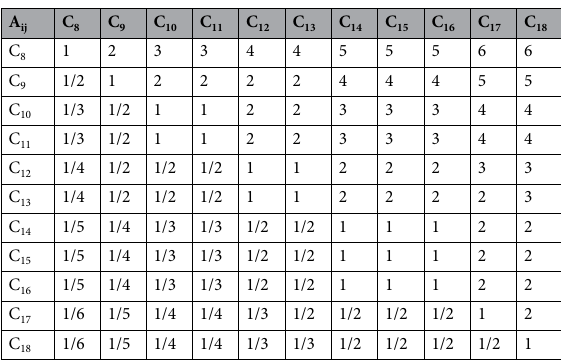
Table 6. Comparative criteria level matrix (Level 2 indicators).